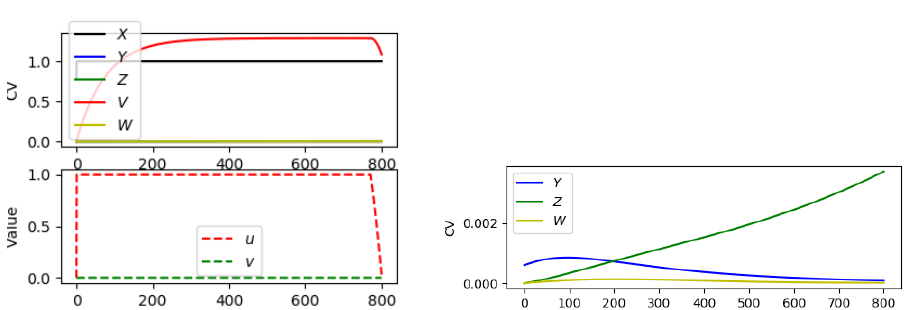
Figure 3. Numerical Optimal Control and Treatment Simulation Results - Low Immunotherapy Side Effect Case